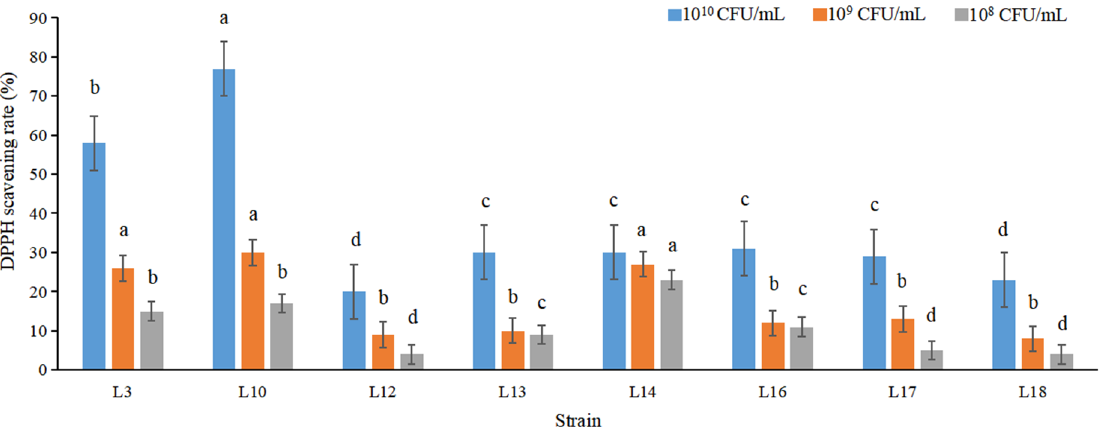
Figure 3. The DPPH radicals scavenging rate (%) of selected 8 strains. The different letters indicated significant difference among treatments ( p <